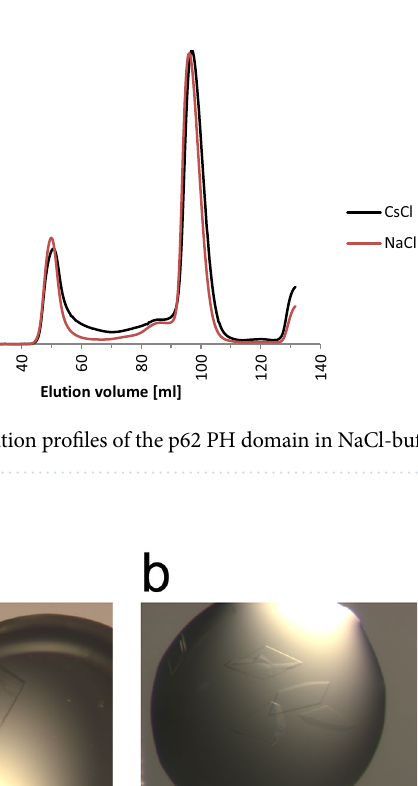
Figure 4. Cesium substructure of HEWL after supplementing with CsCl. HEWL is represented as grey surface, cesium ions are represented as spheres. Orange meshes display the anomalous density contoured at 3 σ. ( a ) Dataset #2: Protein dissolved in a solution containing 0.25 M CsCl and supplemented with 0.25 M CsCl in the cryo-protectant solution. ( b ) Dataset #3: Protein dissolved in H 2 O and supplemented with 1.71 M CsCl in the cryo-protectant solution. ( c ) Dataset #4: Protein dissolved in a solution containing 0.25 M CsCl and supplemented with 1.71 M CsCl in the cryo-protectant solution.